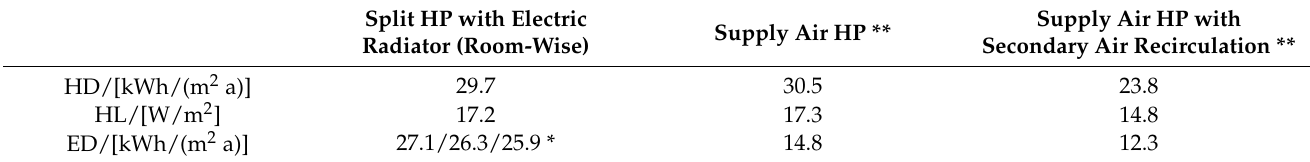
Table 4. Annual space heating demand (HD), maximum hourly heating load (HL), and annual electricity demand (ED) of the three air heating systems (split HP combined with room-wise electric radiators, supply air HP, and supply air HP with secondary air recirculation. Split HP with Electric Radiator